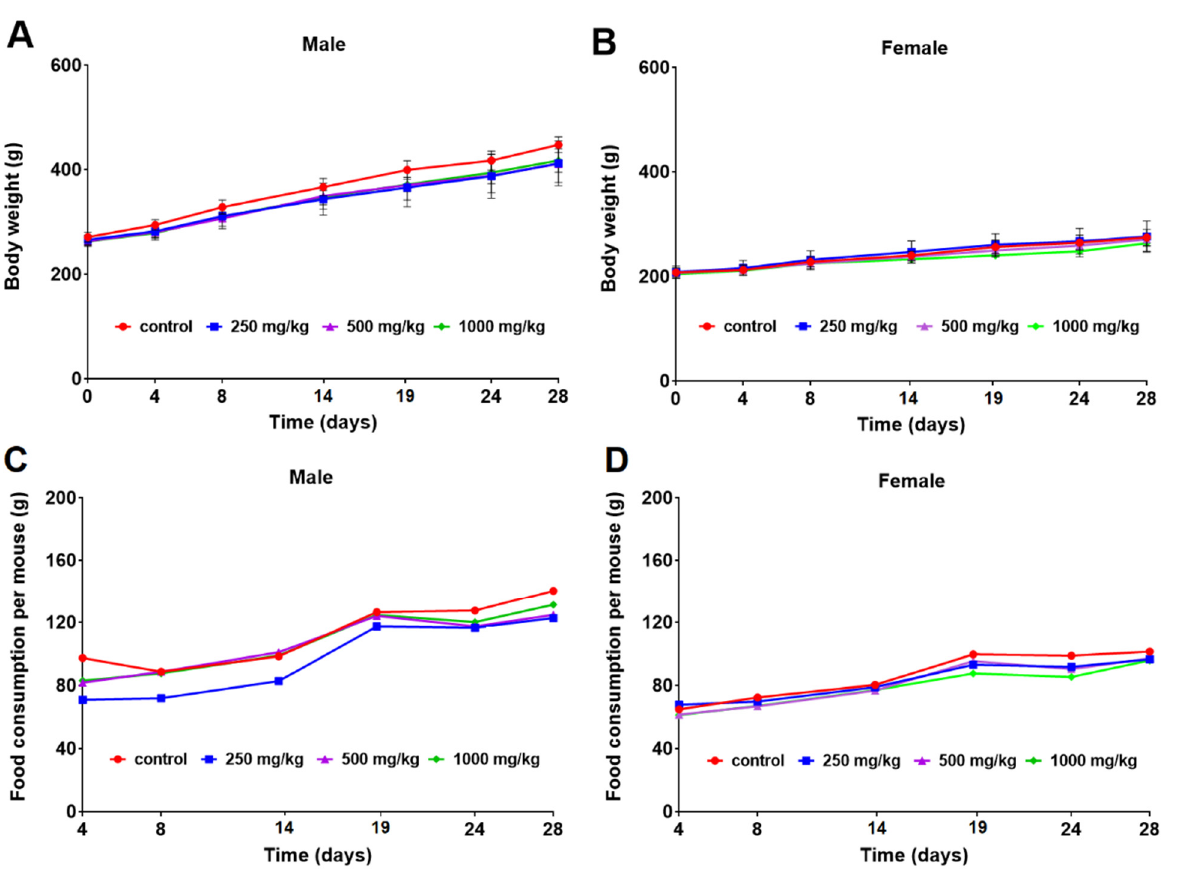
Figure 1. Mean body weights (g) of male ( A ) and female ( B ) rats and food consumption per mouse (g) of male ( C ) and female ( D ) rats orally exposed to 0, 250, 500, and 1000 mg/kg b.w./day curcumol for 28 days.